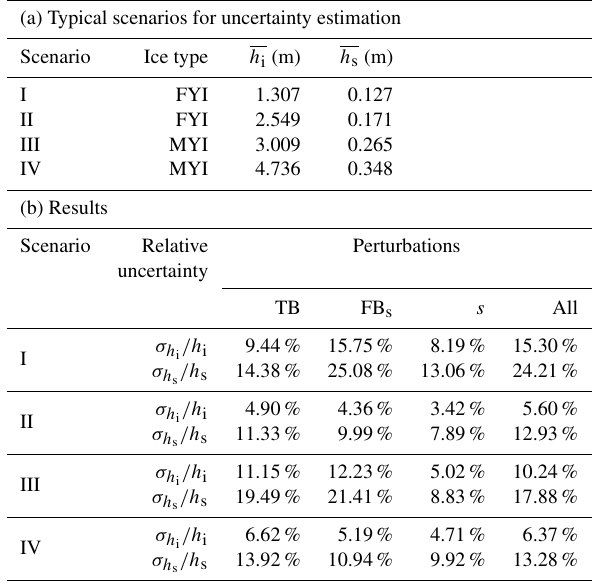
Table 3. Uncertainty estimation for typical retrieval